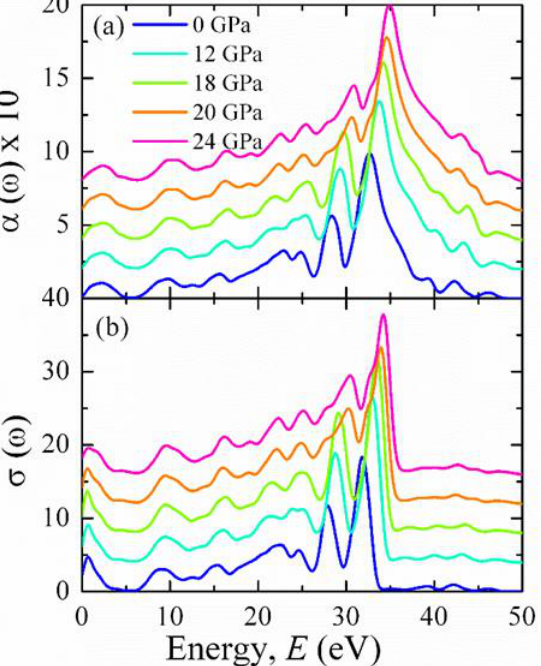
Figure 16. The energy dependence of ( a ) absorption coefficient and ( b ) conductivity of BaCuO 3 at some selected pressures. Different offset values are set to visualize the optical spectra.